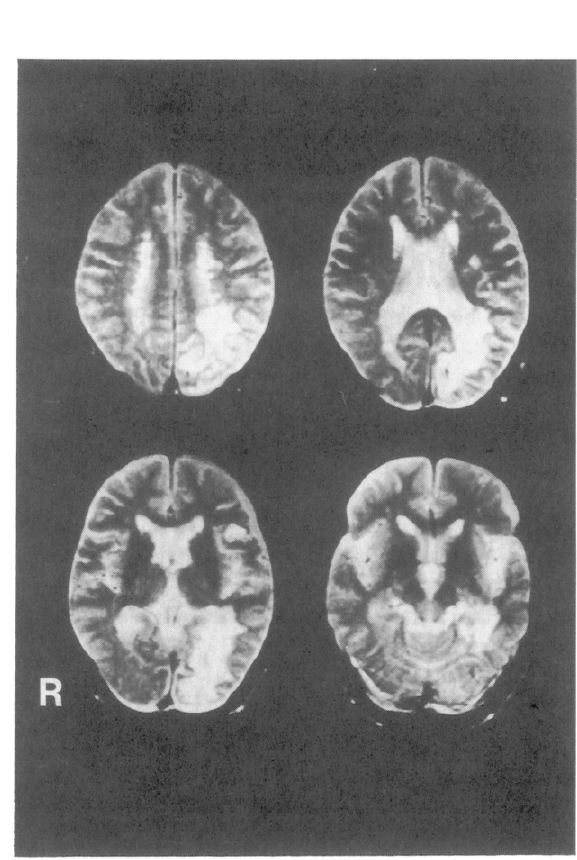
FIG. 2. 1.0 Tesra MRI image with T2 emphasis demonstrates high Signal area In the left occipital lobe. extending upward into the par ietallobe and forward into the medial temporal lobe. The right side of the images corresponds to the left side of the brain.